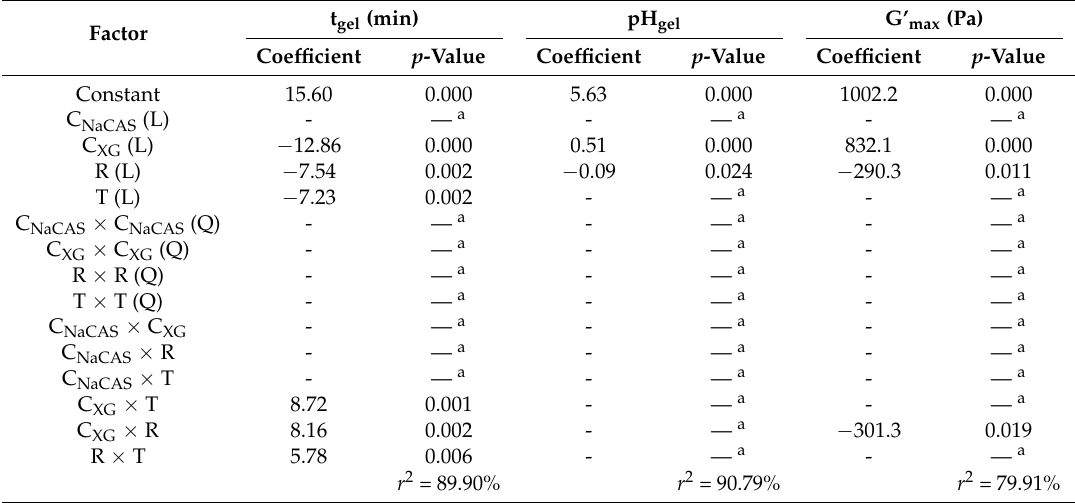
C NaCAS × C XG - — a C XG × T 8.72 0.001 C XG × R 8.16 0.002 5.78 0.006 - r 2 = 89.90% r 2 = 90.79% r 2 = 79.91% L = linear effect; Q = quadratic effect; — a Not